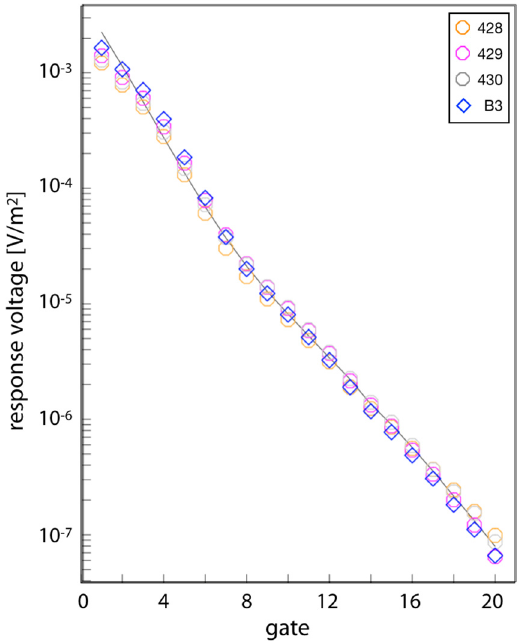
Figure 8. 1D forward modeling result for station 428, 429, 430 and B3 shown as a black line (see column beneath B3 in Figure 9b for the model.).